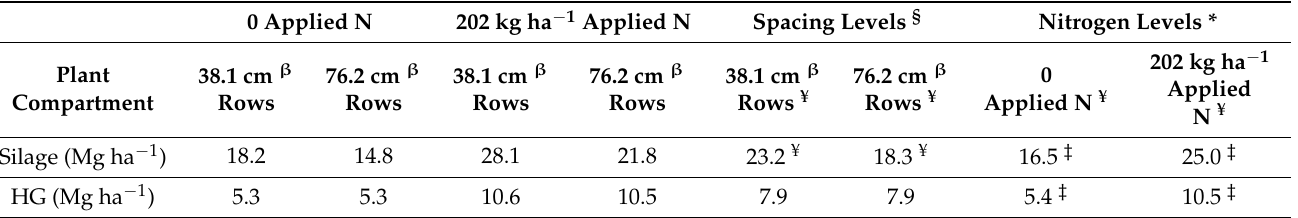
Table 4. Differences in total biomass silage and harvested grain (HG) mean dry weight yields (Mg ha − 1 ) of corn grown in the small plots (study 3) during 2020 under different row spacing systems and nitrogen rates ¶